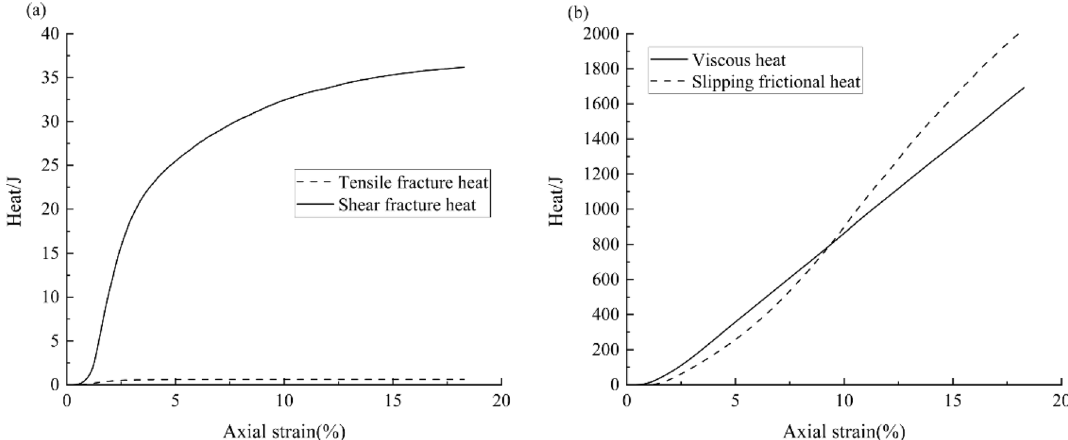
Figure 13. Heat in the model during loading under the 2 MPa confining pressure: ( a ) tensile fracture heat and shear fracture heat; ( b ) viscous heat and slipping frictional